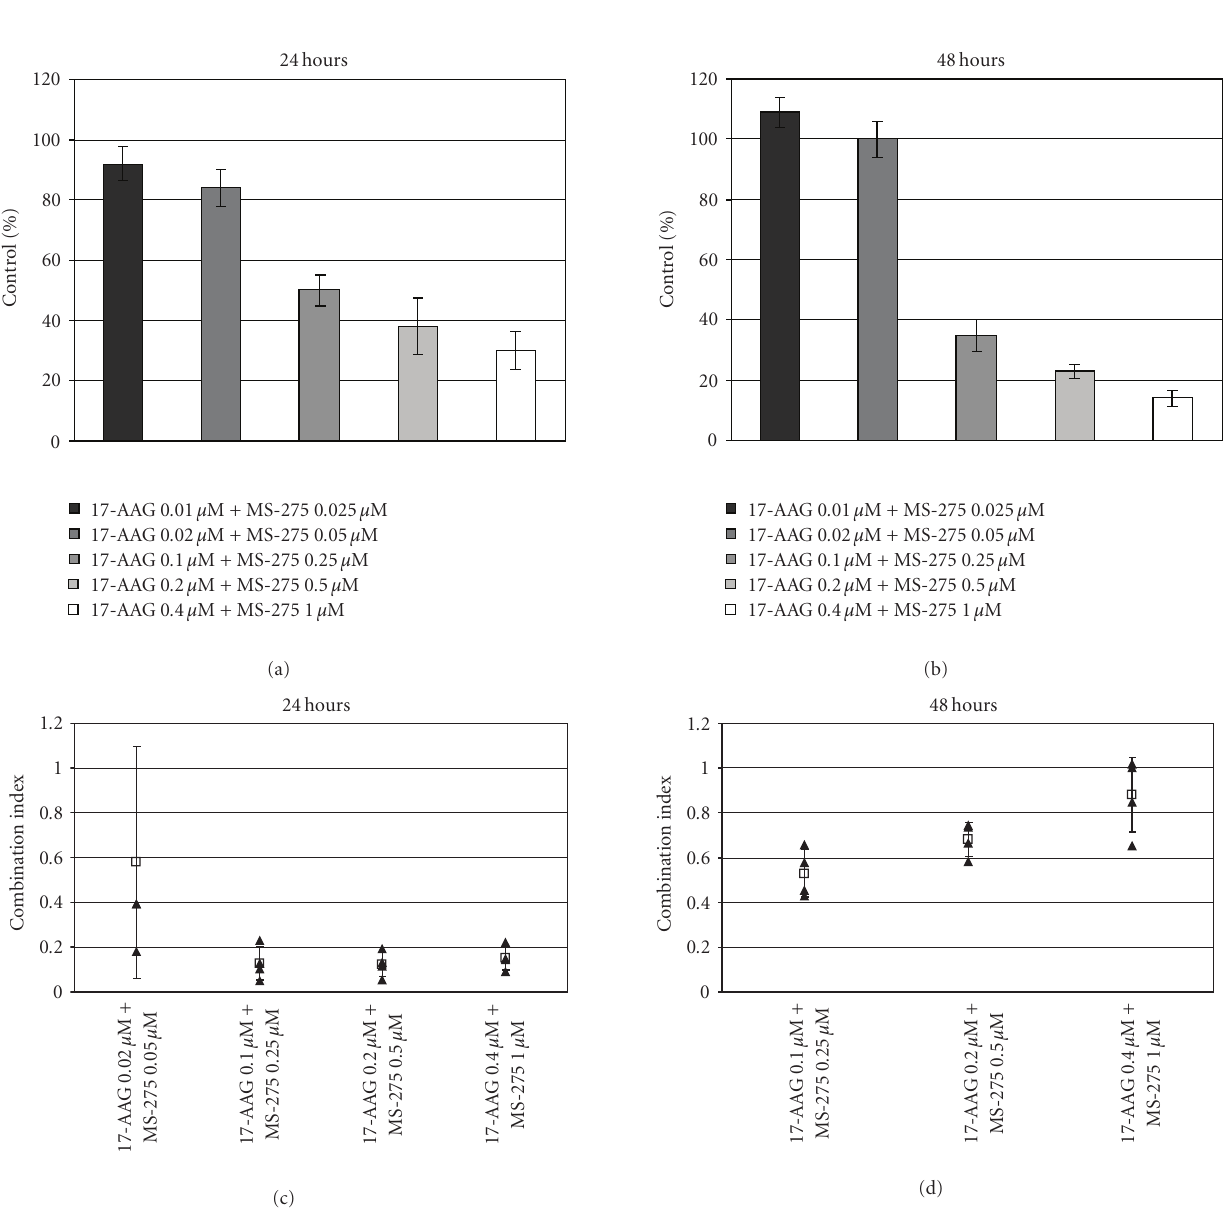
Figure 1: E ff ect of 17-AAG and MS-275 in combination on SYO-1 synovial sarcoma monolayer cultures . Cell survival at (a) 24 hours and (b) 48 hours for drugs combined at a set ratio of 2 parts 17-AAG to 5 parts MS-275. MTT cell proliferation assays were performed for the indicated doses, and survival is plotted relative to vehicle control. Corresponding combination indices are shown for (c) 24 and (d) 48 hours, where values below 1 indicate synergistic drug interactions. Error bars represent 95% confidence intervals. Combination indices were calculated using the Chou and Talalay Median Dose Method (not applicable at low doses where e ff ective cell killing relative to control cell death was not